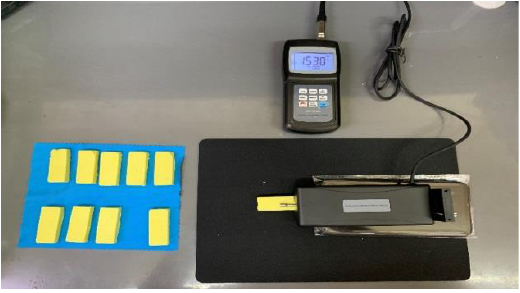
Figure (6): surface roughness